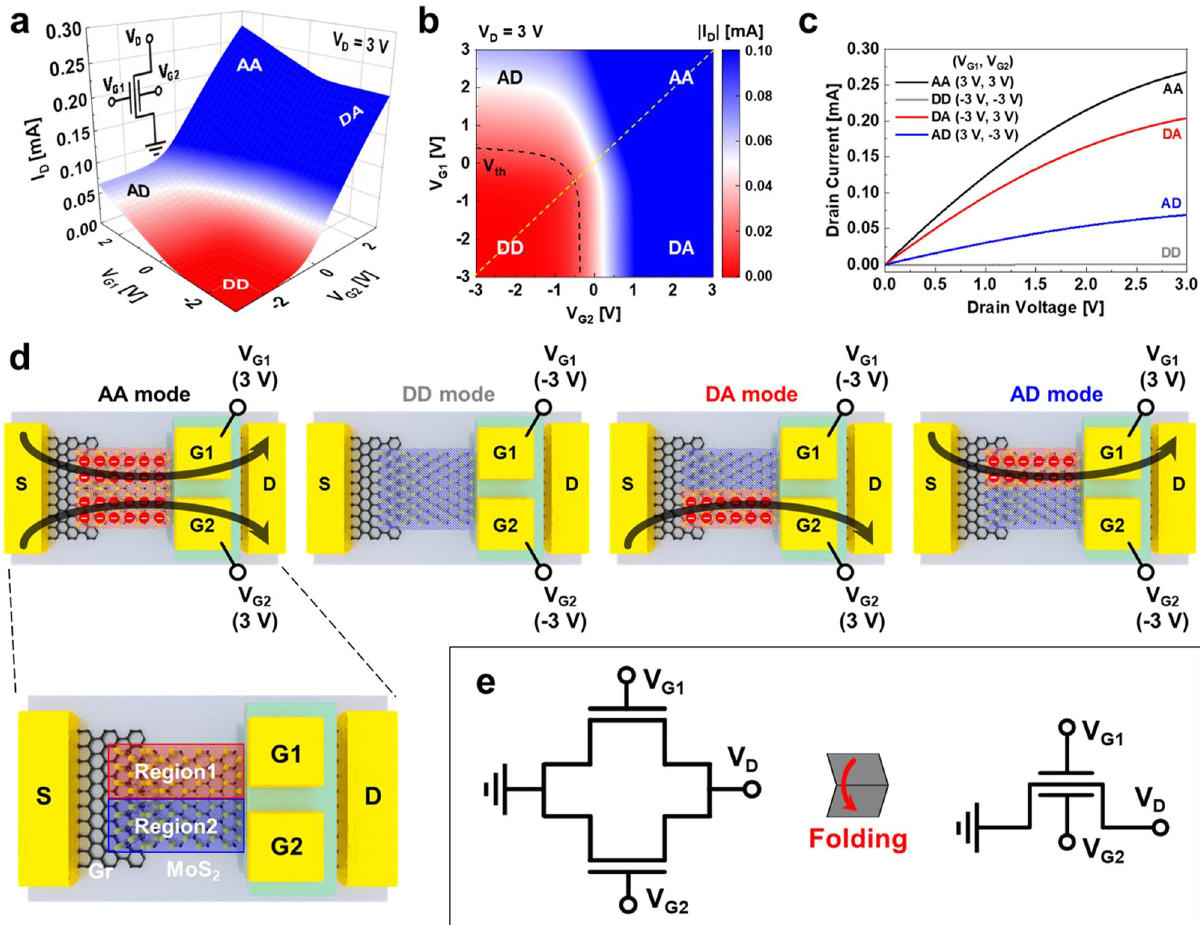
Fig. 3 Electrical characteristics and operating schematics of OR-FET. a , b 3D color surface ( a ) and contour color map ( b ) of I D in OR-FET at each V G1 and V G2 value in the range from – 3 to 3 V with V D of 3 V. c I D – V D output characteristics of the four distinct transition modes of the OR- FET. d The operating schematics for the four distinct transition modes (AA, DD, DA, and AD modes). e Circuit diagrams showing how the same switching function can be realized with a single transistor (vertically folded